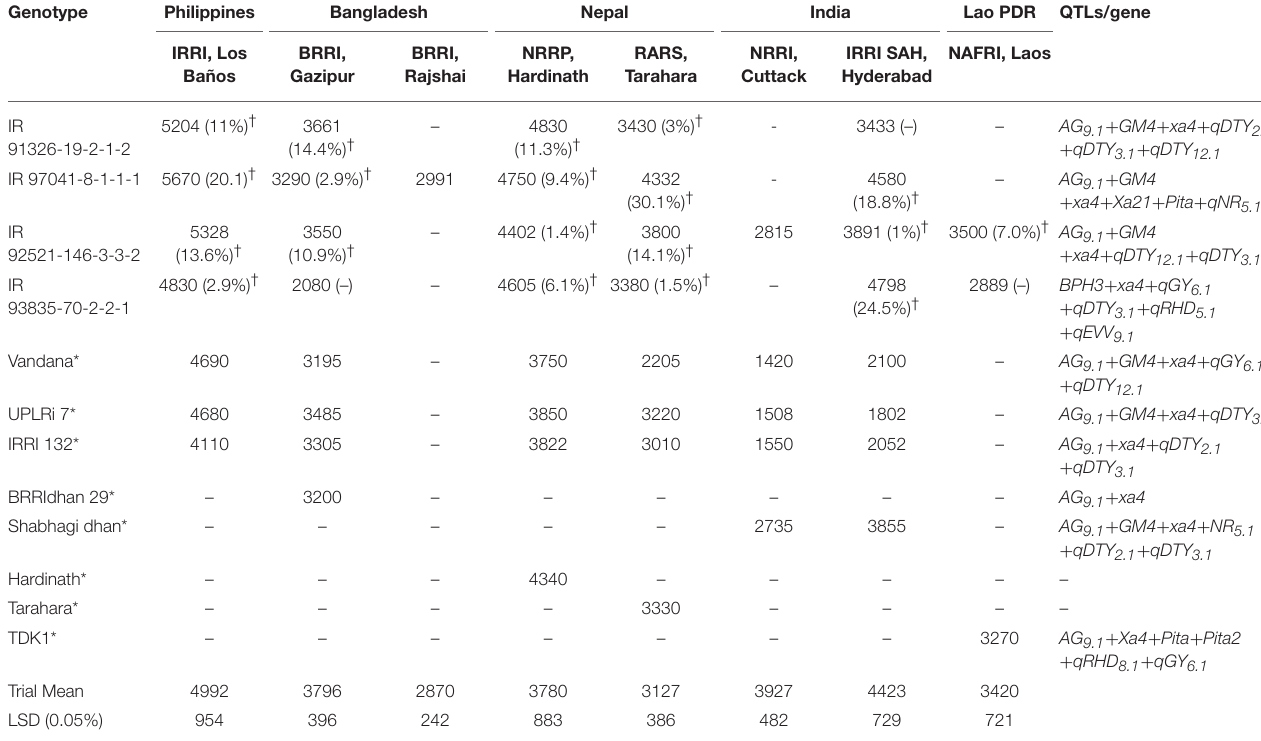
TABLE 7 | Mean grain yield (Kg ha − 1 ) of selected stable genotypes across different ecosystems and QTLs for traits increasing rice adaptation under aerobic situation and resistance/tolerance to biotic stresses.